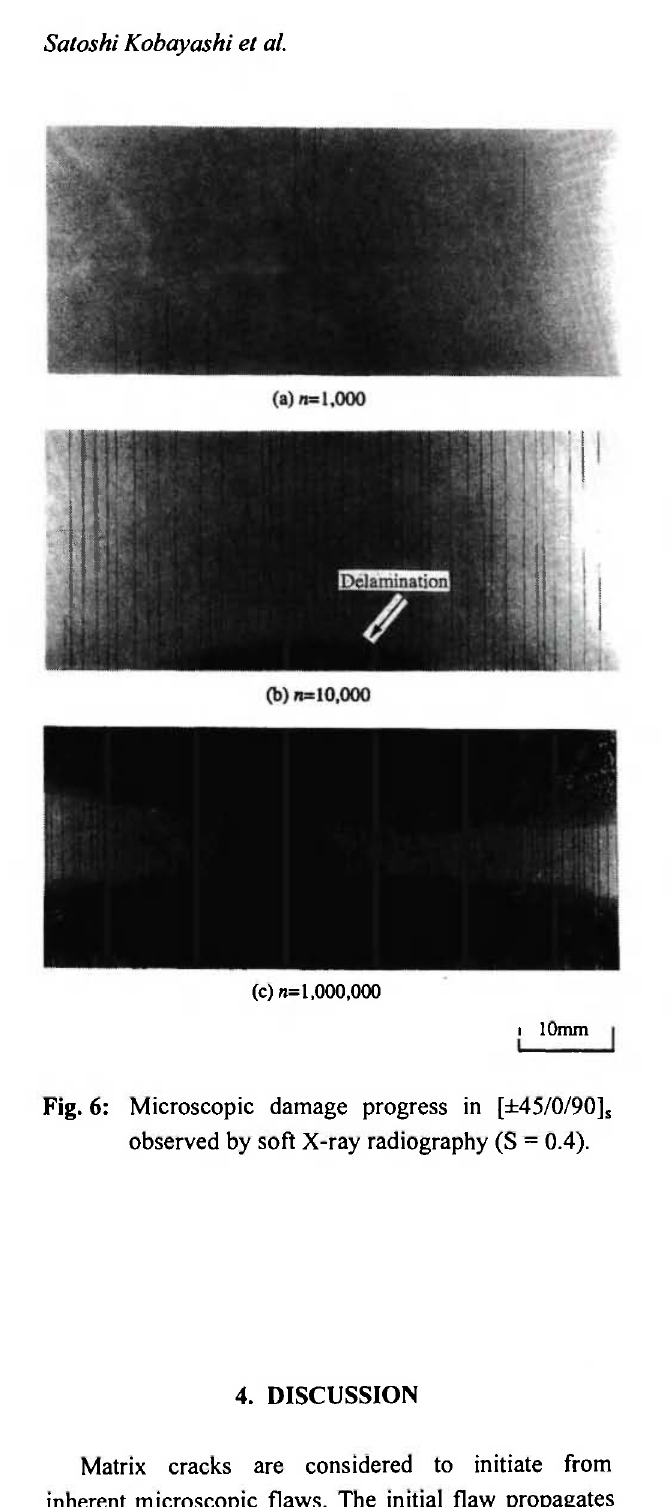
Fig. 6: Microscopic damage progress in [±45/0/90] s observed by soft X-ray radiography (S =